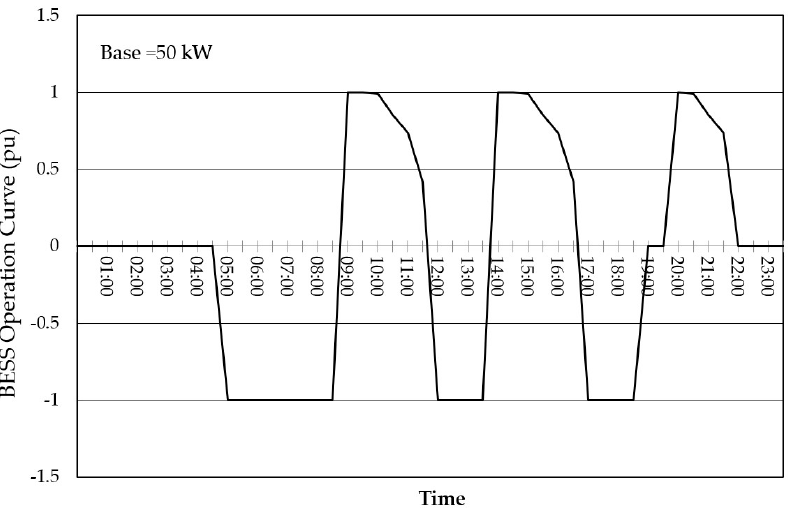
Figure 13. The normalized operation curve of a 50-kW BESS.